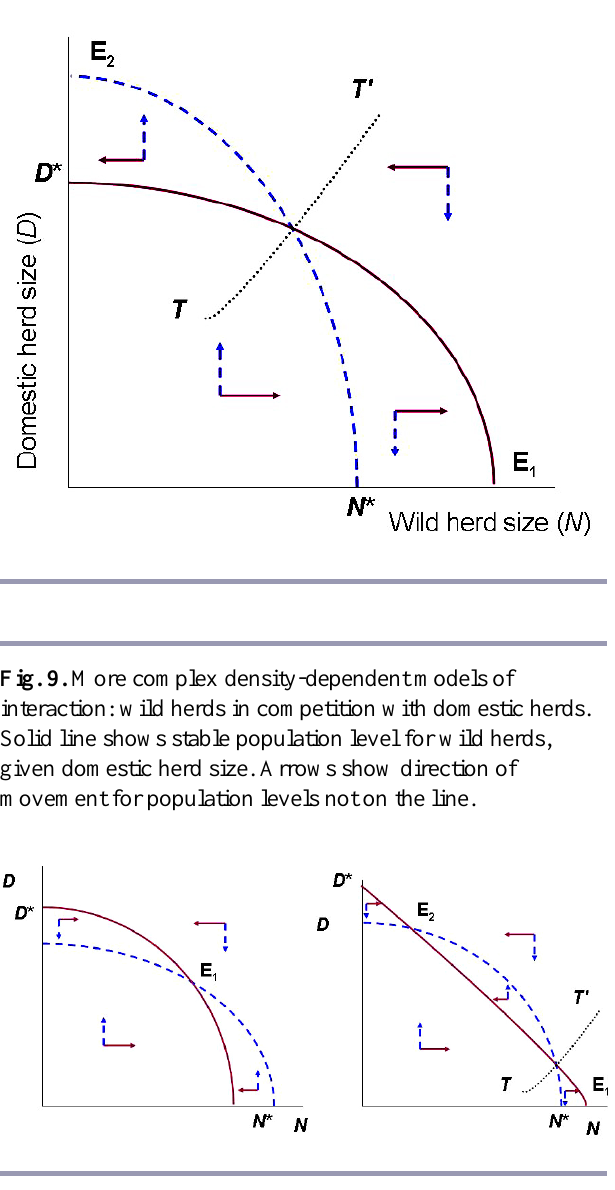
Fig. 6. Simple density-dependent models of interaction of wild (N) and domestic (D) herds. Solid line shows potential equilibrium solutions. Arrows show direction of change from positions out of equilibrium (N=horizontal, D= vertical)